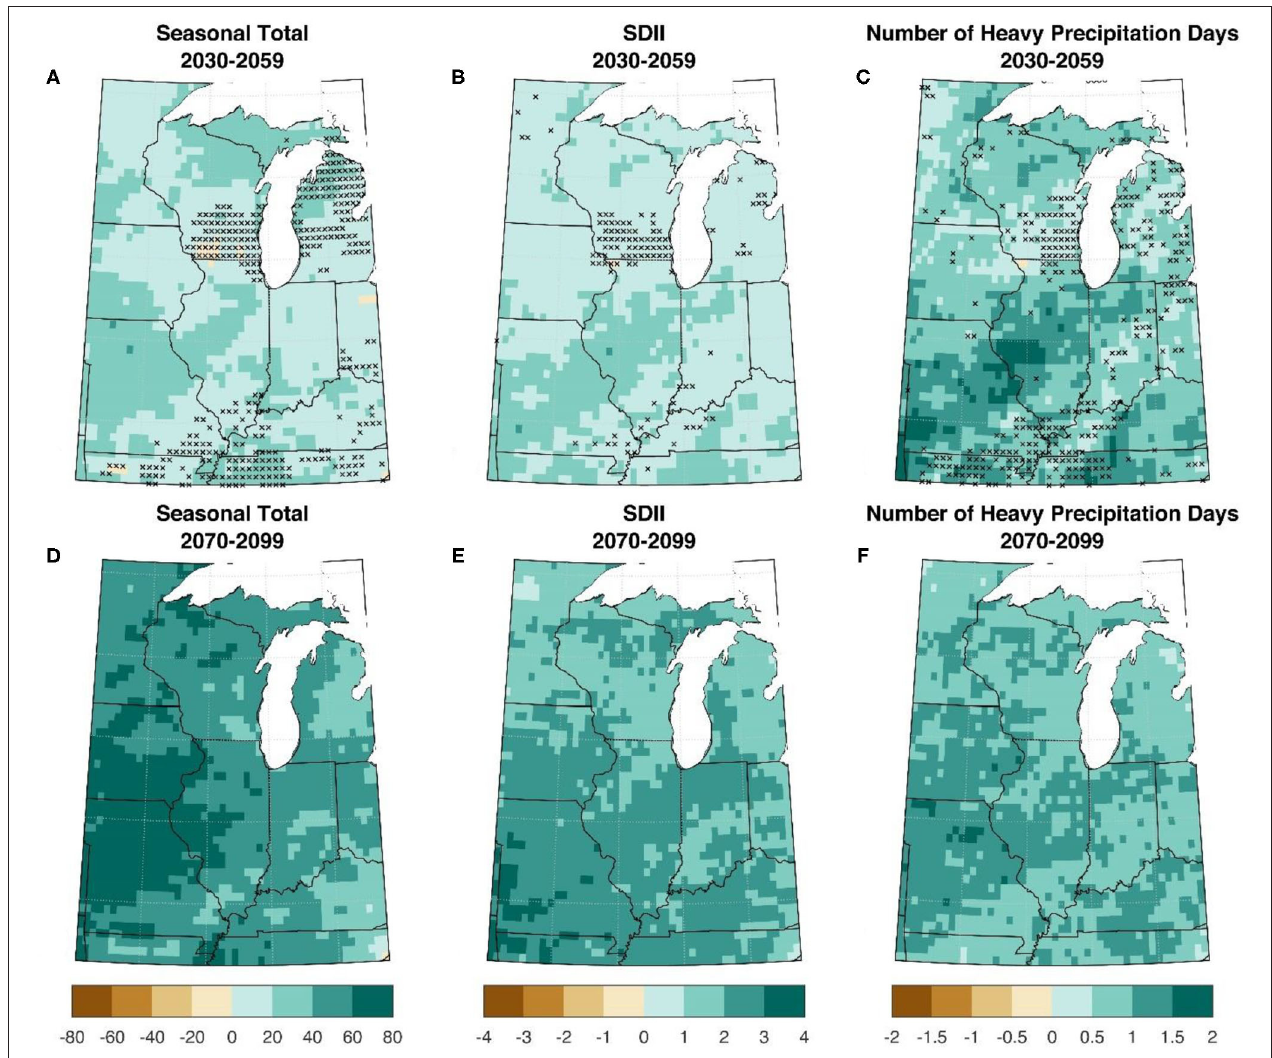
FIGURE 3 | Projected changes in the 30-year spring climatology of the NA-CORDEX multi-model ensemble median in mid- (2030–2059) and late-century (2070–2099), relative to the model historical period (1976–2005). Maps show the seasonal precipitation totals [ (A,D) , inches], SDII [ (B,E) , mm day − 1 ], and heavy precipitation day frequency [ (C,F) , days]. Stippling represents areas where fewer than 9 of the 12 simulations agreed on the sign of the